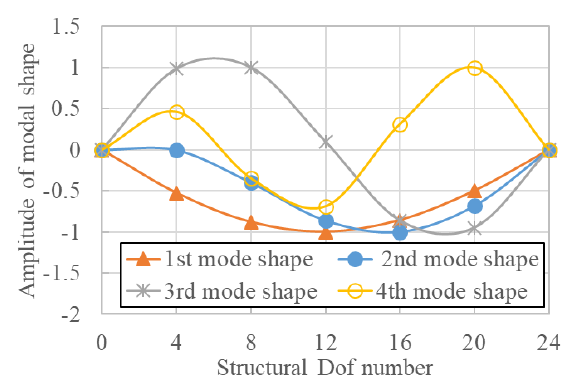
Figure 6. First four orders of vertical mode shapes.